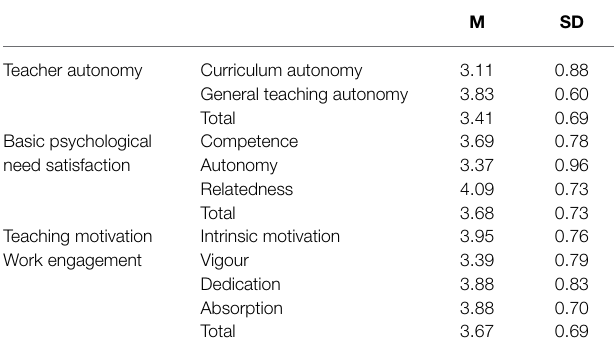
TABLE 2 | Descriptive analysis for main variables ( n = 520).